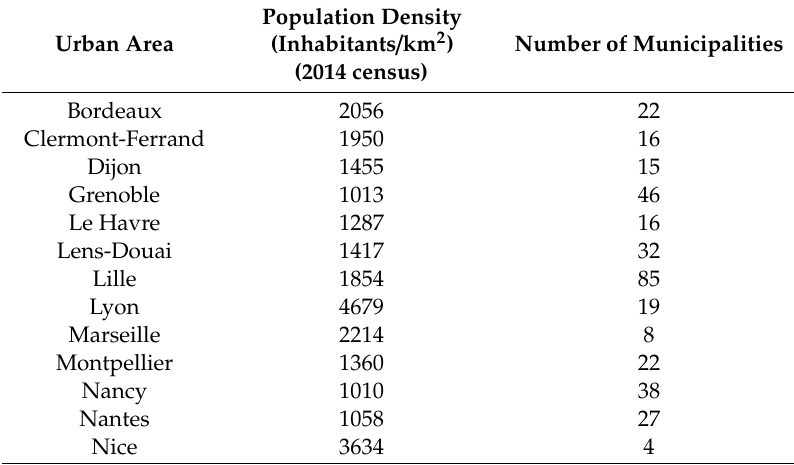
Table A1. Population density in 18 French areas: